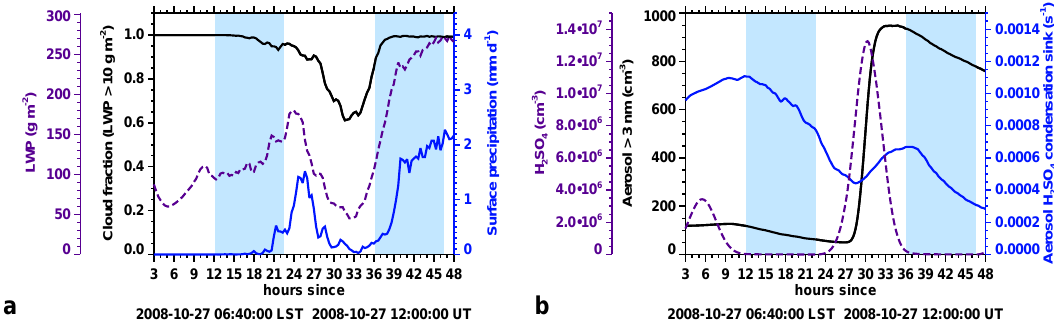
Fig. 3. Time series from simulation S 0 of (a) domain-averaged liquid water path, cloud fraction, and precipitation, and of (b) gas phase sulfuric acid concentration, concentration of aerosol particles larger than 3nm in dry diameter, and aerosol sulfuric acid condensation sink, averaged over cloud-free locations in the boundary layer. Light blue shading indicates